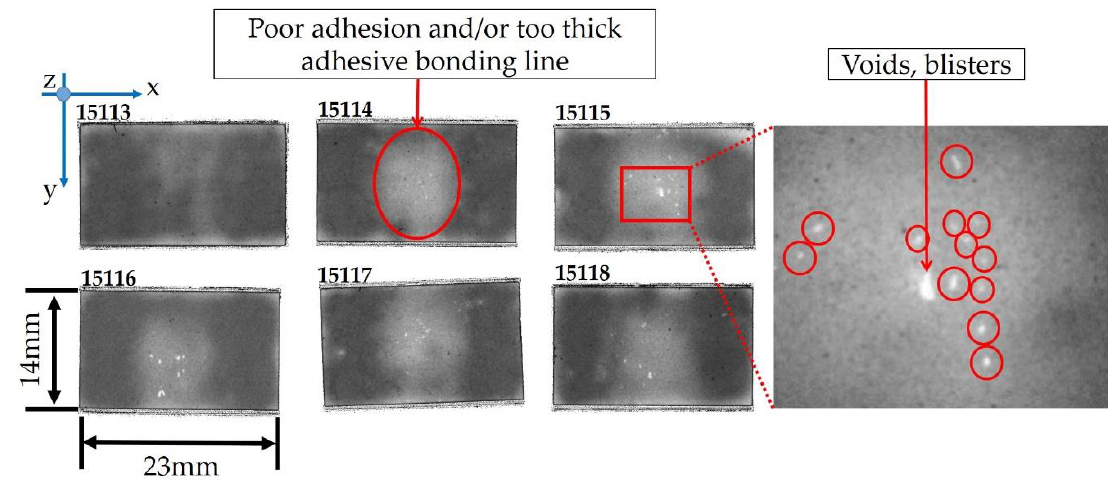
Figure 10. C-scan of the adhesive 1 between the matching layer and piezoelectric material (lot #1).